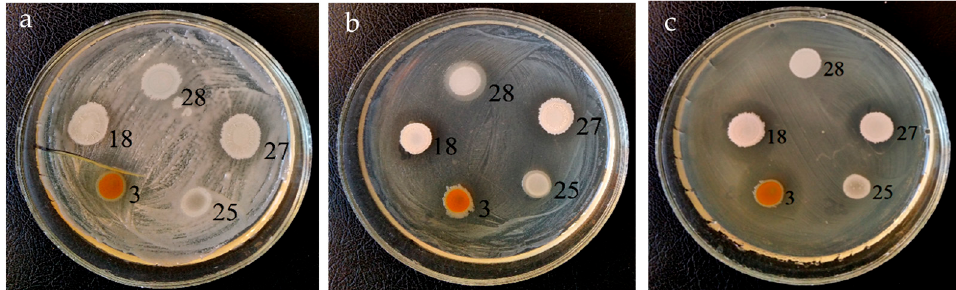
Figure 2. Antibacterial activity of soil strains 3, 18, 25, 27 and 28 towards Ralstonia sp. 1-7 ( a ), Pecto- bacterium carotovorum subsp. carotovorum VKM B-1247T ( b ) and Pectobacterium wasabiae B15 ( c ) after 7 days of cultivation.